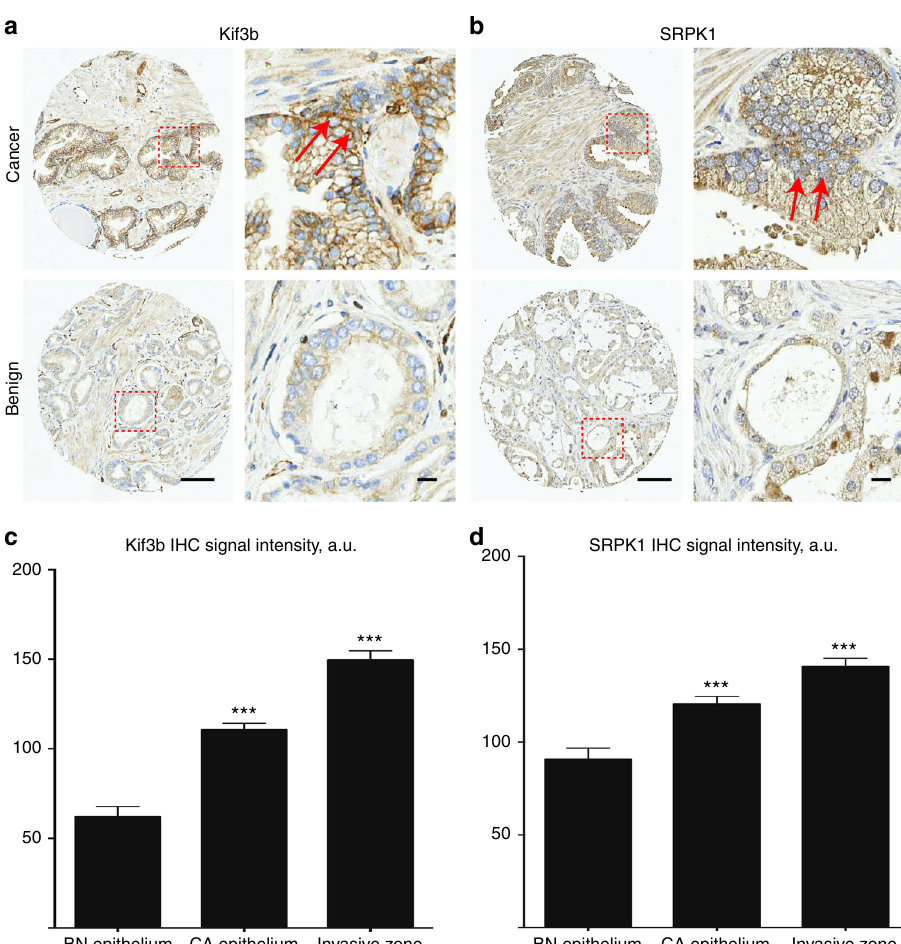
Fig. 6 KIF3B and SRPK1 are overexpressed in invasive prostate cancer epithelium. The expression of KIF3B and SRPK1 in 98 prostate cancer patients was assessed by immunohistochemistry. Representative prostate tissue sections stained with Kif3b ( a ) and SRPK1 ( b ) antibodies in areas with prostate cancer (upper panels) and benign prostate hyperplasia (lower panels) samples. Right panels in ( a ) and ( b ) show enlarged areas from within the red dashed squares. Red arrows denote prostate cancer invasive zones. Quanti fi cation of KIF3B ( c ) and SRPK1 ( d ) expression within the epithelium in prostate benign hyperplasia, prostate cancer epithelium, and prostate cancer invasive zones. Scale bars = 100 μ m ( a, b , left panels) and 10 μ m ( a , b , right